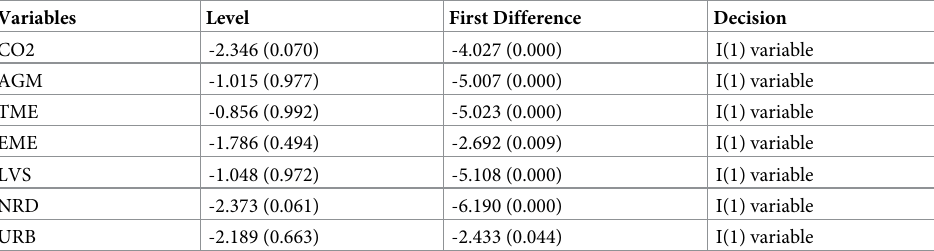
Table 6. Pesaran’s CADF unit root test